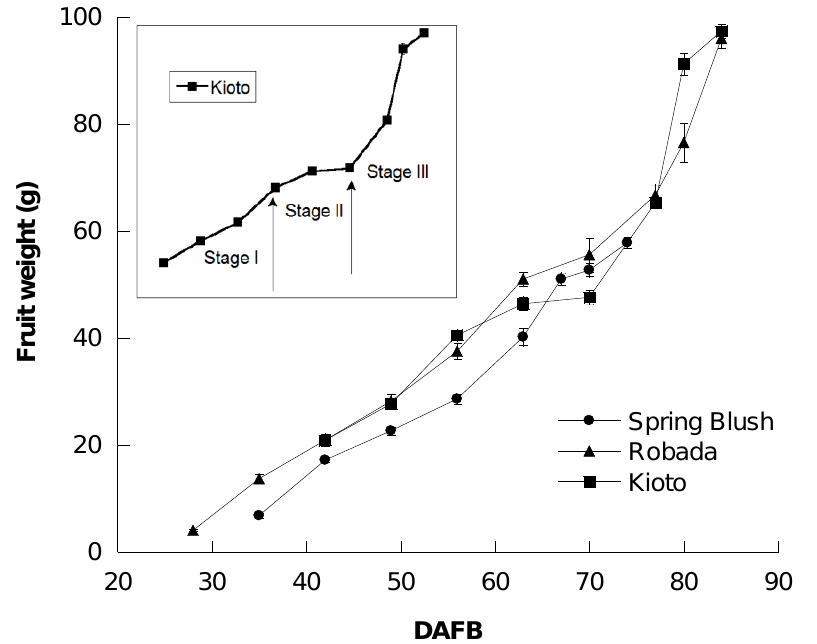
Figure 1. Fruit growth curve (expressed in g) of the three studied apricot cultivars. Days after full bloom (DAFB) to commercial maturity, indicating stages I, II, and III of the growth for the ‘Kioto’ cultivar. Mean values ± standard error (n = 20).